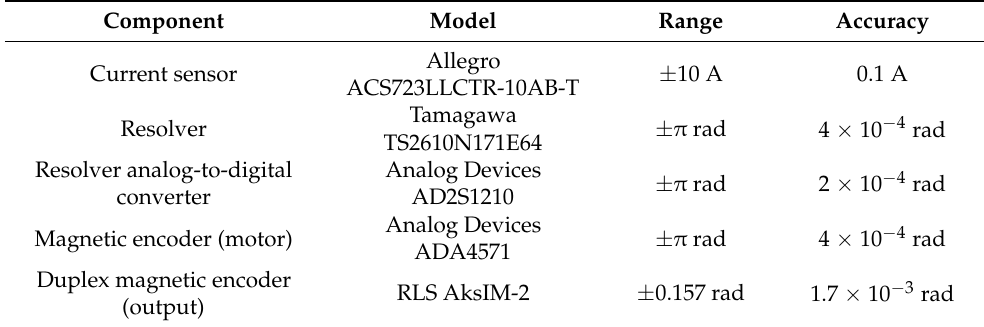
Table 1. EMA control sensors